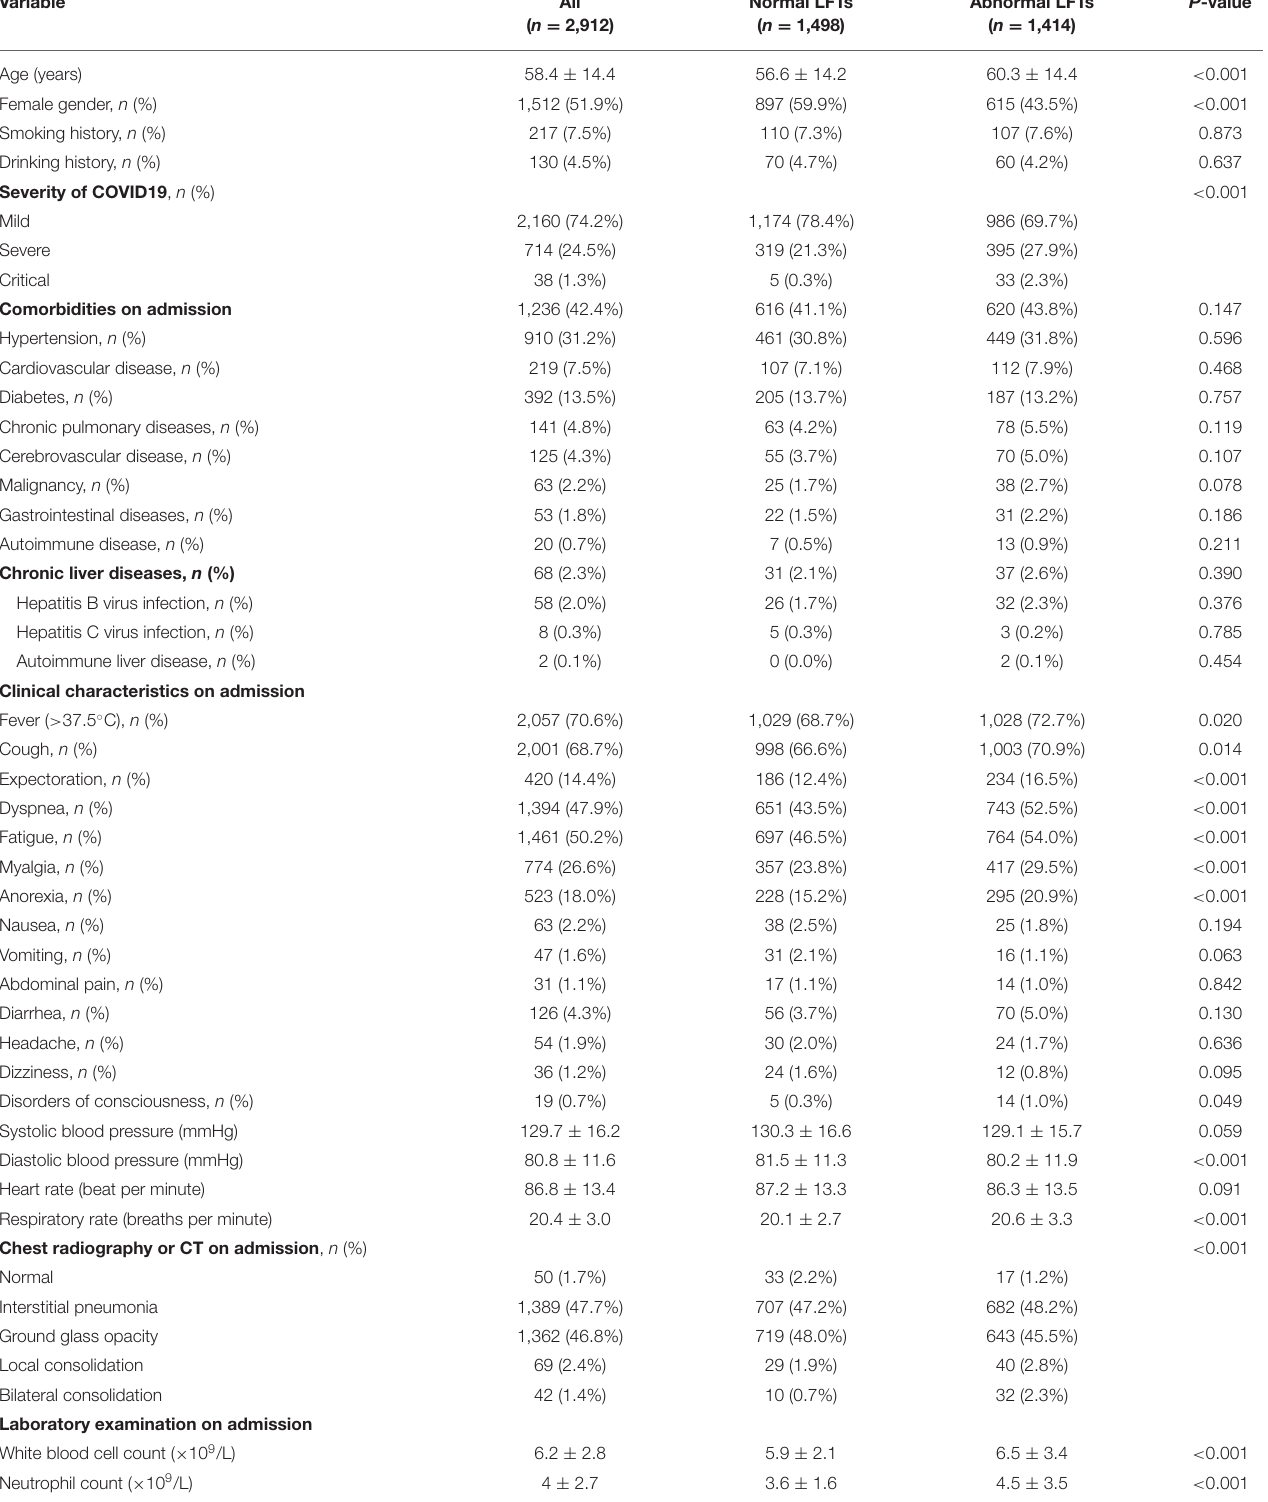
TABLE 1 | Baseline characteristics of patients according to normal vs. abnormal liver function test on admission.